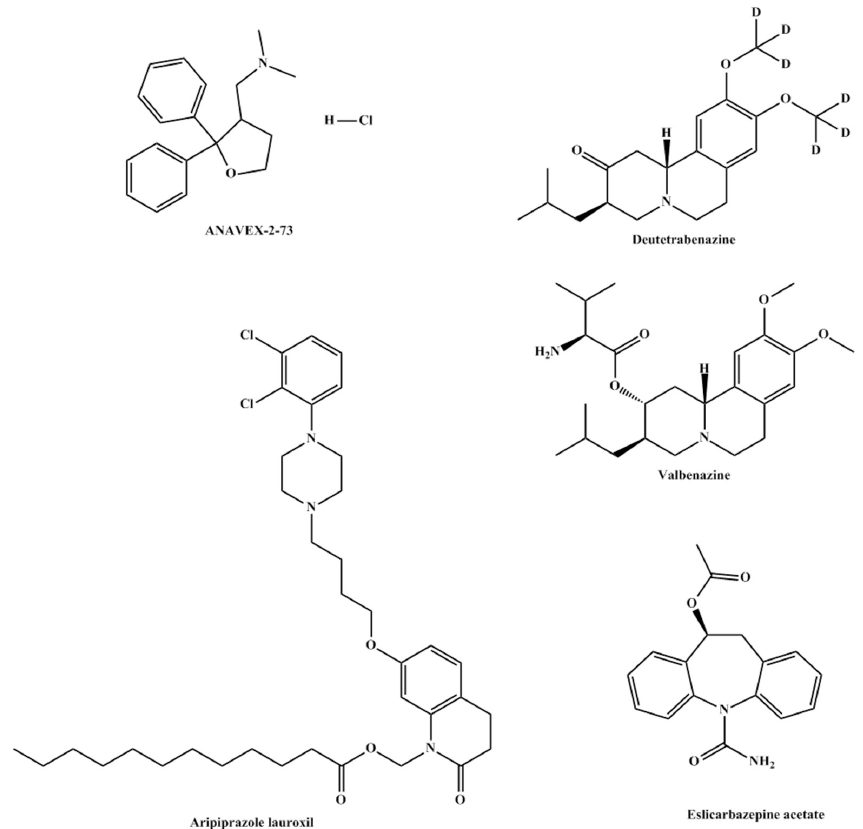
Figure 2. Structure of prodrugs reported in this sub-section.